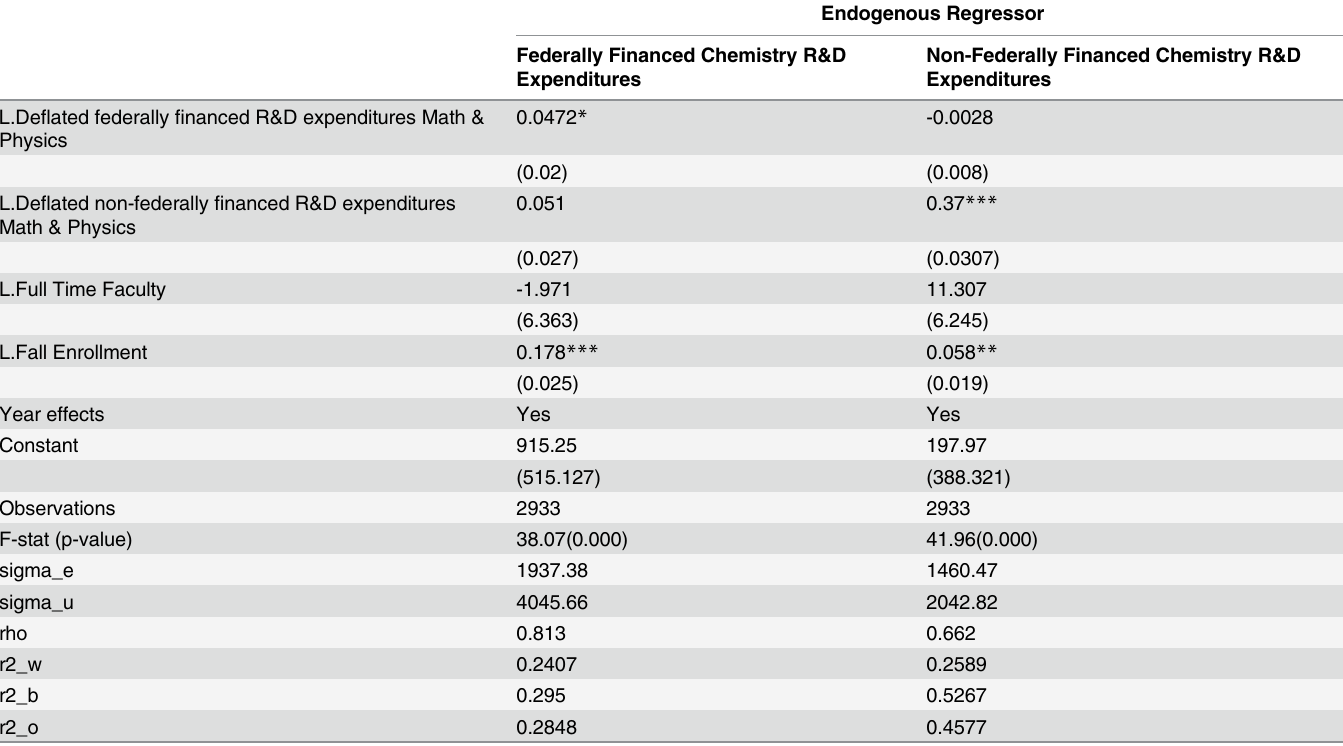
Table 4. First Stage IV Regressions Determinants of Number of